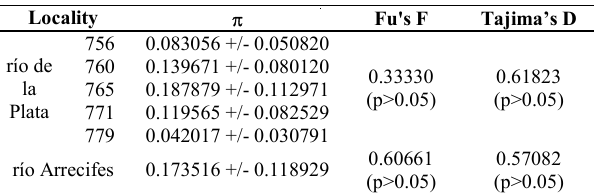
Table 4. Pairwise corrected genetic distances for Pimelodus albicans among all the collecting sites (below diagonal) and values of the corresponding standard error computation by bootstrap (500 replicates) (above